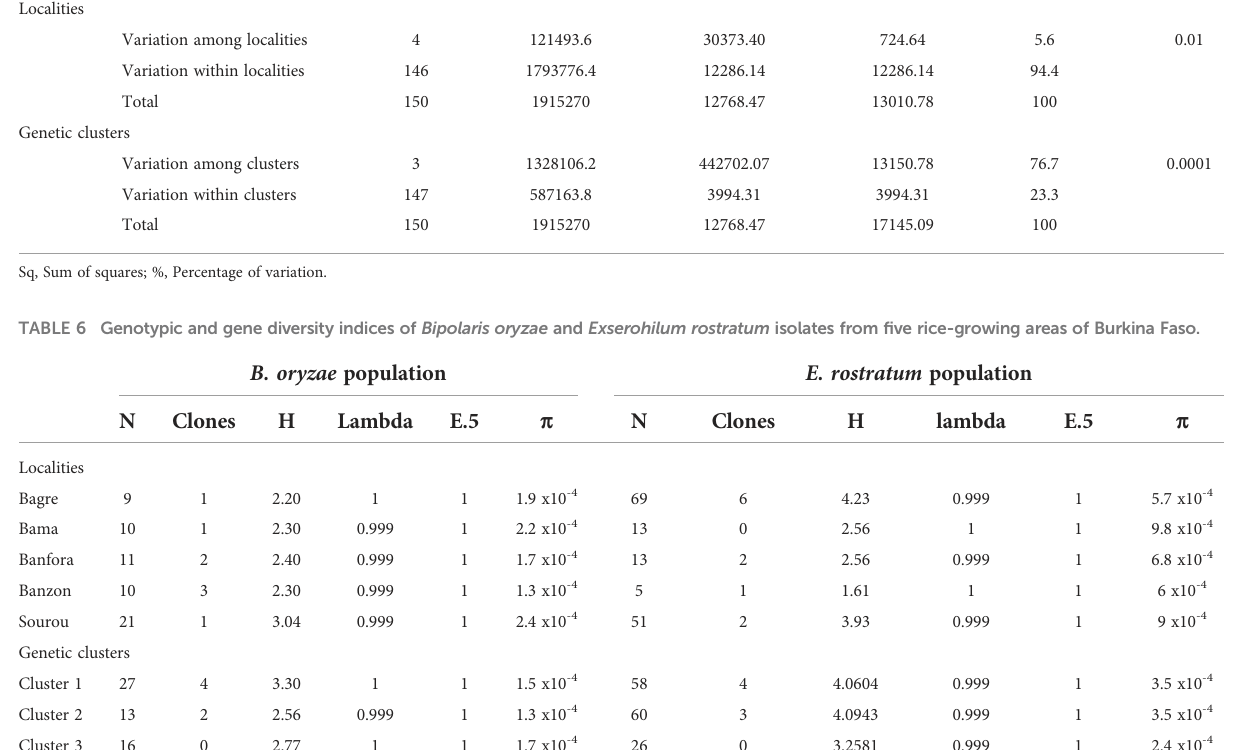
TABLE 5 Analysis of molecular variance (AMOVA) of Exserohilum rostratum among and within fi ve rice-growing zones in Burkina Faso. df Localities Variation among localities Variation within localities